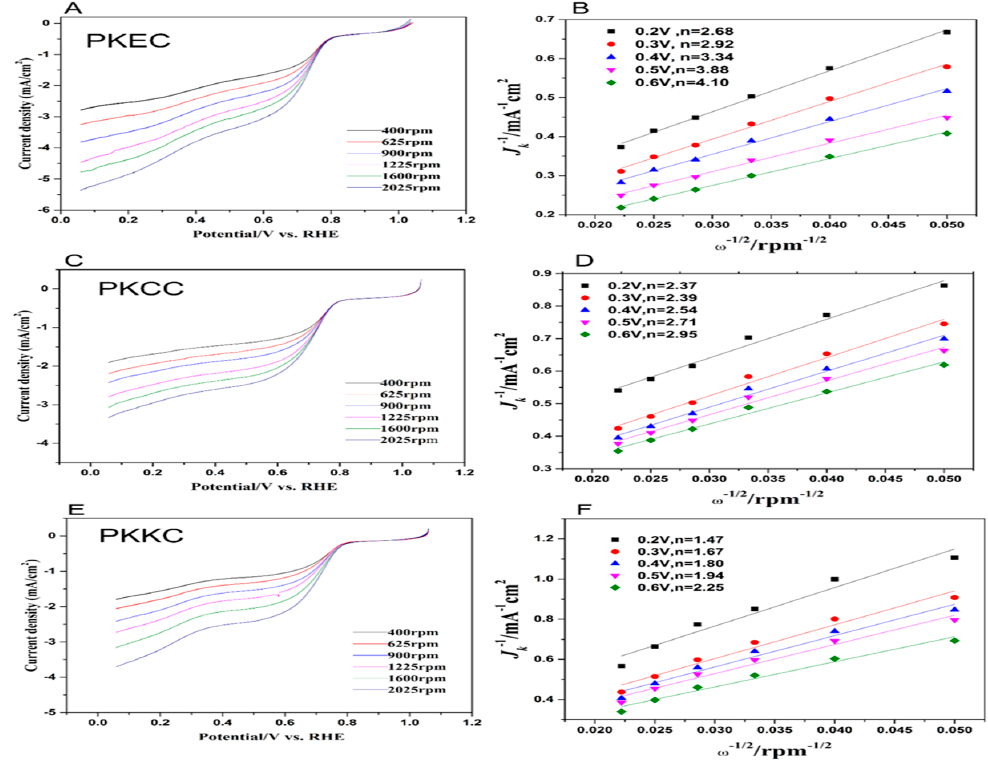
Figure 2. LSV curves of PKEC ( A ), PKCC ( C ) and PKKC ( E ) in O 2 saturated 0.1 M KOH at di ff erent rotation speeds and K-L diagrams of PKEC ( B ), PKCC ( D ) and PKKC ( F ) at di ff erent